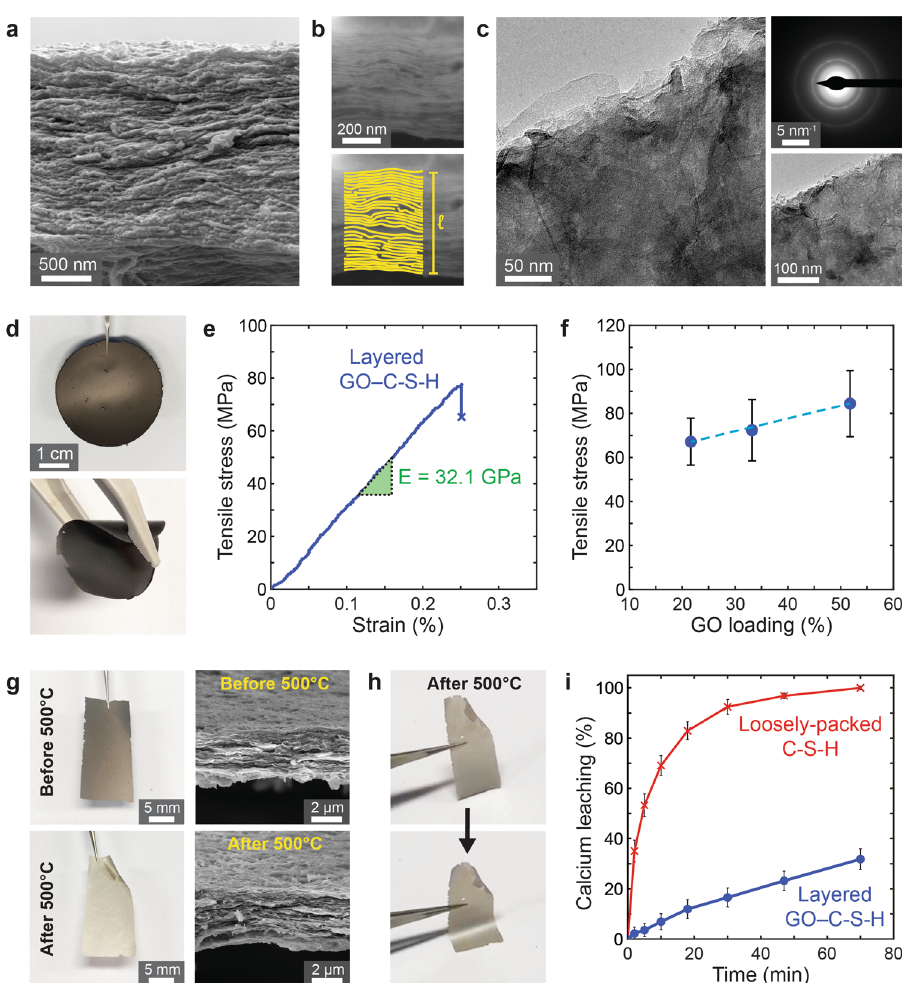
Fig. 5 Nano-engineered layer-by-layer GO – C – S – H with superior mechanical, anti-cracking and chemical properties. a SEM images of the cross-section of the layered GO – C – S – H with C – S – H:GO mass ratio of ~2. b Cross-section of the layered GO – C – S – H fabricated using a focused-ion-beam instrument. The bottom panel shows the same image as the top panel. Representative lines indicate the layer-by-layer arrangement of the GO – C – S – H nanosheets. The average thickness of a single layer (~10 – 15 nm) was calculated by dividing the number of layers by the composite total thickness. c TEM image of the layered GO – C – S – H. The top-right and bottom-right images in ( c ) show the selected area electron diffraction and the lower-magni fi cation image of the same area, respectively. d Digital camera photograph showing the fl exibility of the layered GO – C – S – H composite. e Tensile stress – strain curve of the layered GO – C – S – H composite. f Tensile strength of layered GO – C – S – H composites with different GO loading ratios. Error bars represent the standard deviation of quadruplicate experiments. g Digital camera and SEM images showing the layered GO – C – S – H composite before and after exposure to 500 °C for 1 h. h Digital camera photographs showing the fl exibility of the layered GO – C – S – H composite after exposure to 500 °C for 1 h. i Percentage of calcium ions leached from the layered GO – C – S – H structure into ultrapure water over time, compared with loosely packed C – S – H (without control). Error bars represent the standard deviation of duplicate